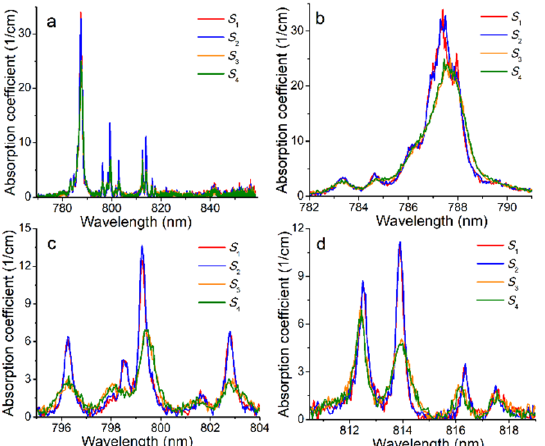
Figure 2. Room-temperature absorption spectra of Er:YAG (S 1 , S 2 ) and Er:YSAG (S 3 , S 4 ) ceramics in the range of 4 I 15/2 → 4 I 9/2 electron transitions: ( a ) 770–860 nm, ( b ) 780–900 nm, ( c ) 795–805 nm, and ( d ) 810–820 nm.